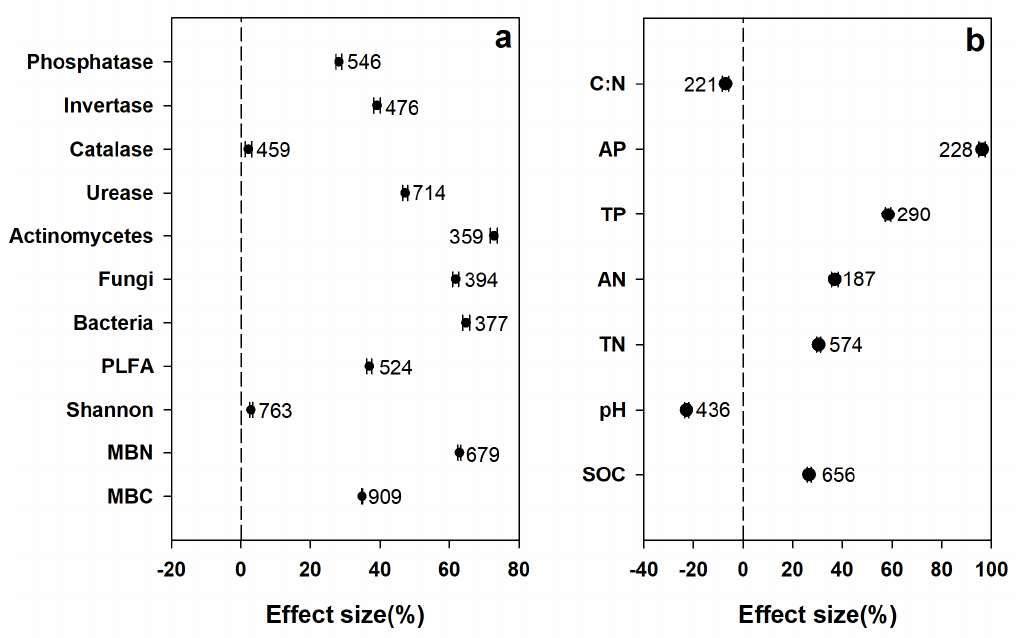
Figure 2. The effect sizes of fertilization on soil microbial properties (MBC, MBN, the Shannon index, PLFA, bacteria, fungi, Actinomycetes , urease, catalase, invertase and phosphatase) ( a ) and soil chemical properties (SOC, pH, TN, AN, TP, AP, and C:N ratio) ( b ) by meta − analysis. The numbers approximating the black dots are the data numbers. MBC: microbial biomass carbon; MBN: microbial biomass nitrogen; PLFA: phospholipid fatty acid; SOC: soil organic carbon; TN: total nitrogen; AN: alkali − hydrolysable nitrogen; AP: available phosphorus; and TP: total phosphorus.